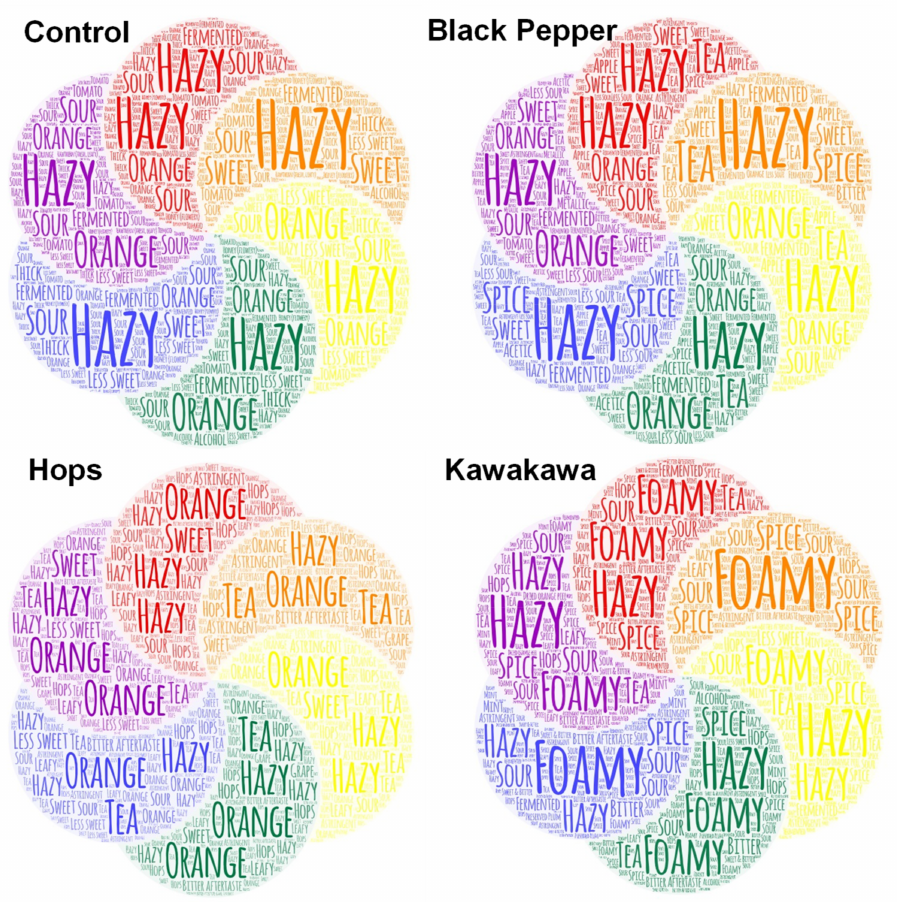
Figure 1. Word clouds originated from the focus group, showing the most agreed attributes for the Kombucha